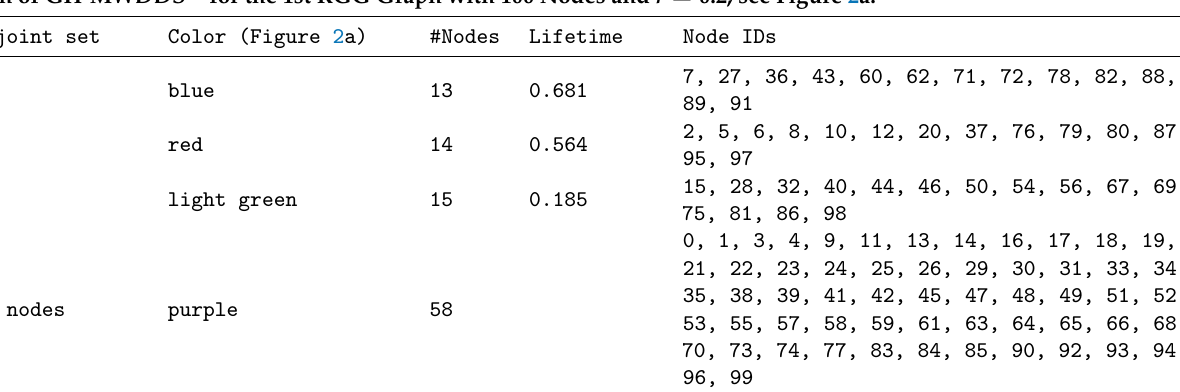
Table 4. Detailed textual description of the solutions displayed in Figures 2 and